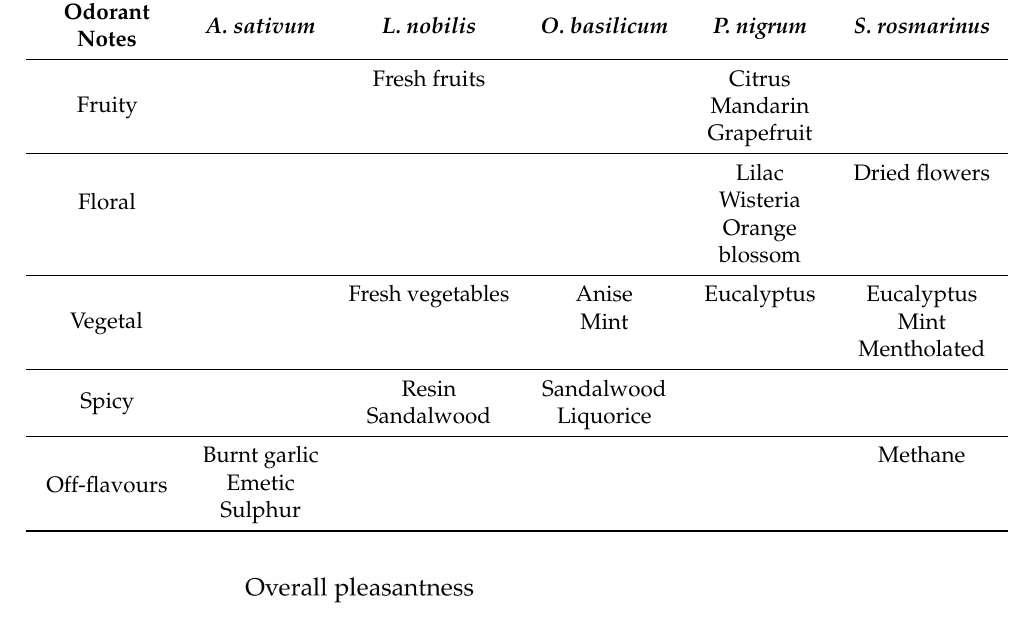
Table 2. Main odours that characterised the smell of the Allium sativum , Laurus nobilis , Ocimum